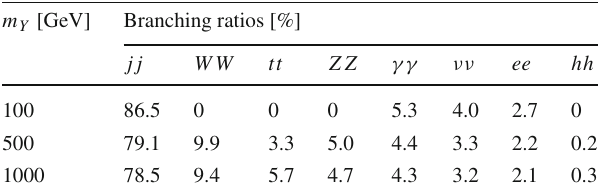
Table 1 Branching ratios of the spin-2 mediator for g SM = 1 and B ( Y 2 → X X ) = 0; jj includes gluons and five flavours of quarks, and νν includes three flavours of